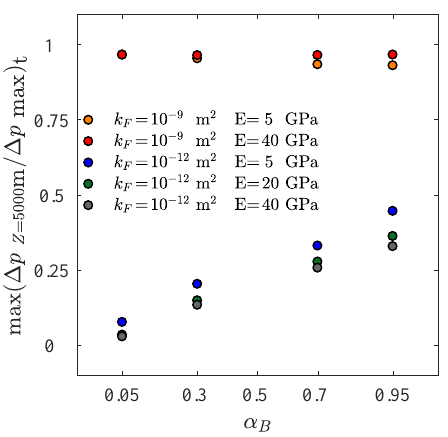
Figure 6. Impact of both the poroelastic response and specific storage on pore pressure diffusion through the fault zone. Here we represent the effect of the Biot coefficient ( α B = 0.05,0.3, 0.7, and 0.95) on the relative pressure at 5 km deep (referred to the maximum value of the surface pore pressure). We consider two values of the fault permeability ( k F = 10 − 12 and 10 − 9 m 2 ) and diverse values of the Young modulus for the ground (E = 5,20 and 40 GPa). The rock stiffness has little effect on the pore pressure diffusion throughout the fault. On the other hand, the more impermeable the fault, the bigger the poroelastic effect. The Young modulus of the fault is 5 GPa and rock intrinsic permeability is 10 − 16 m 2 . Table 2 details the remaining parameters of the simulations.